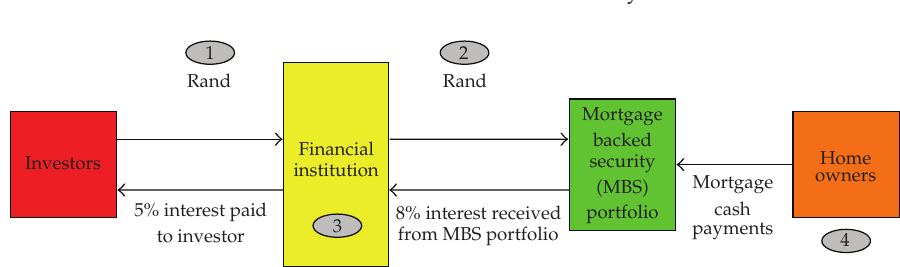
Figure 10: Diagrammatic Overview of the Financial Leverage Profit Engine (cid:2) compare (cid:5) 51 (cid:6)(cid:3)